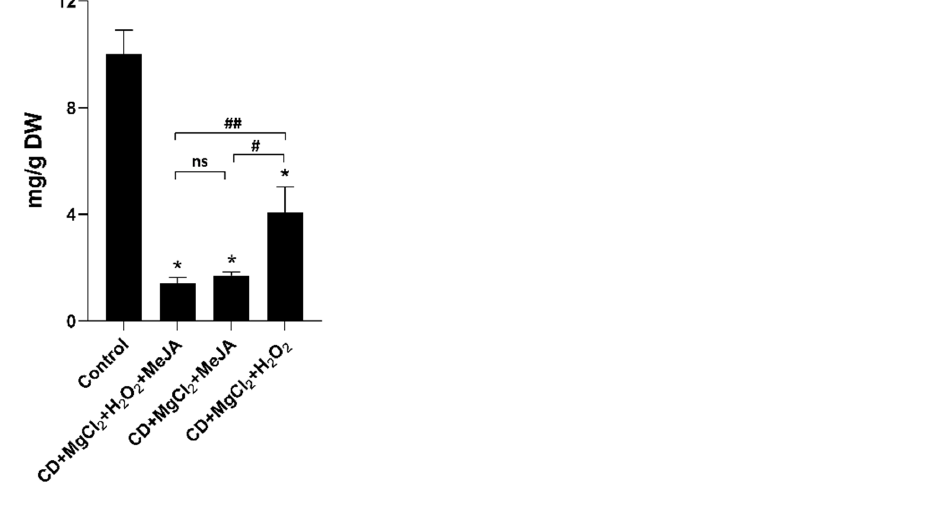
Figure 8. Yield of mulberroside A in the hairy root tissue after 192 h of treatment with multiple elicitors. Values are the mean of four biological replicates, and error bars represent the standard deviation. * p < 0.0001 treatment vs. control; # p < 0.001, ## p < 0.0005, ns, not significant among treatments.